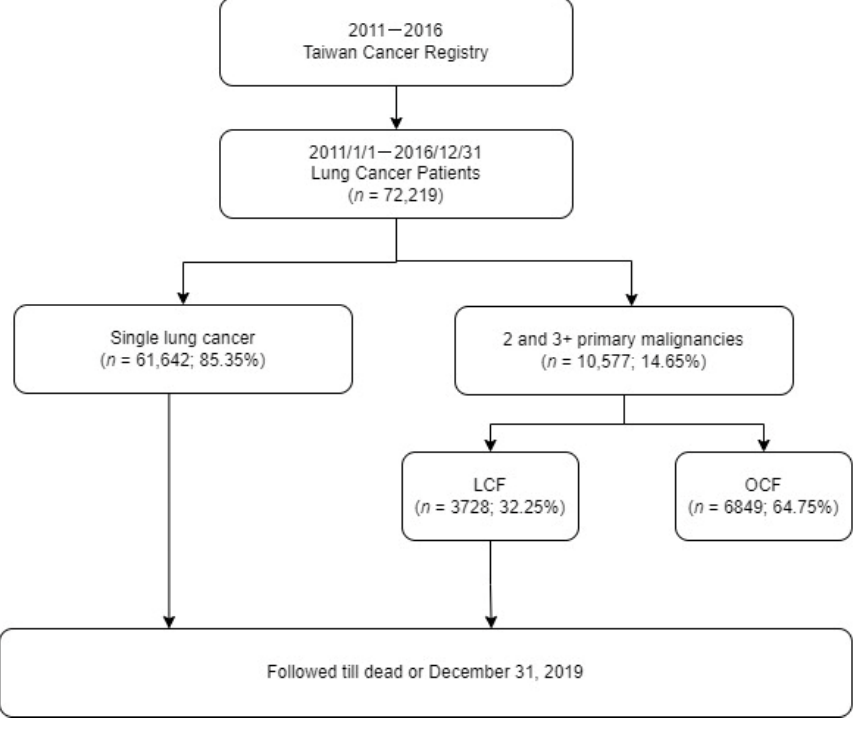
Figure 1. Research flow chart.